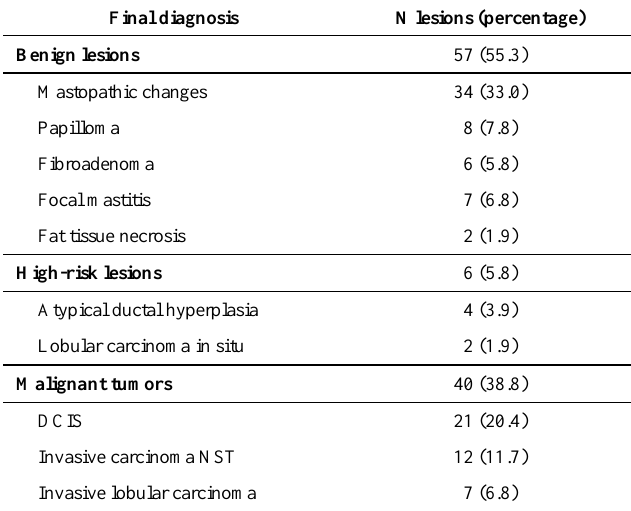
Table 1. Pathohistological diagnosis in 103 non-mass lesions